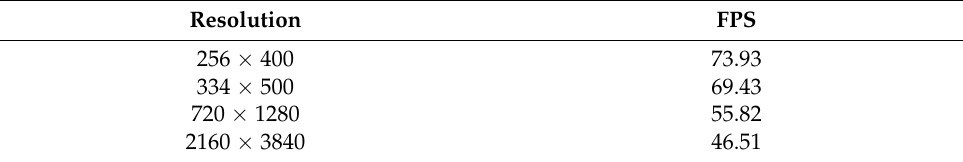
Table 2. The detection speed of TCA-YOLO for images of different